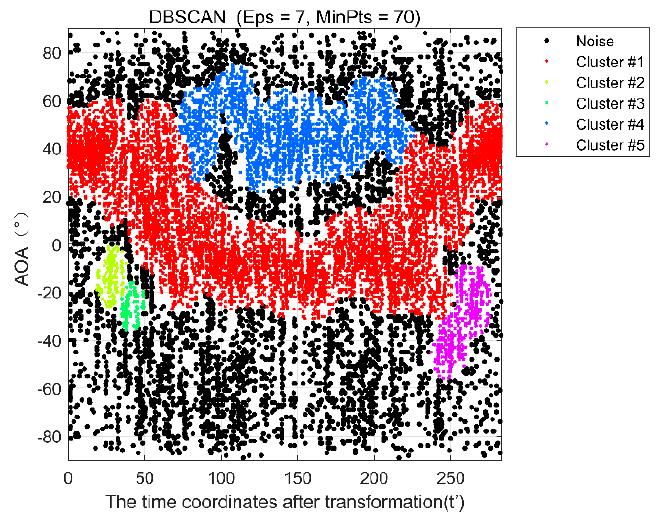
Figure 6. AOA spatiotemporal clustering results with adaptive parameters.